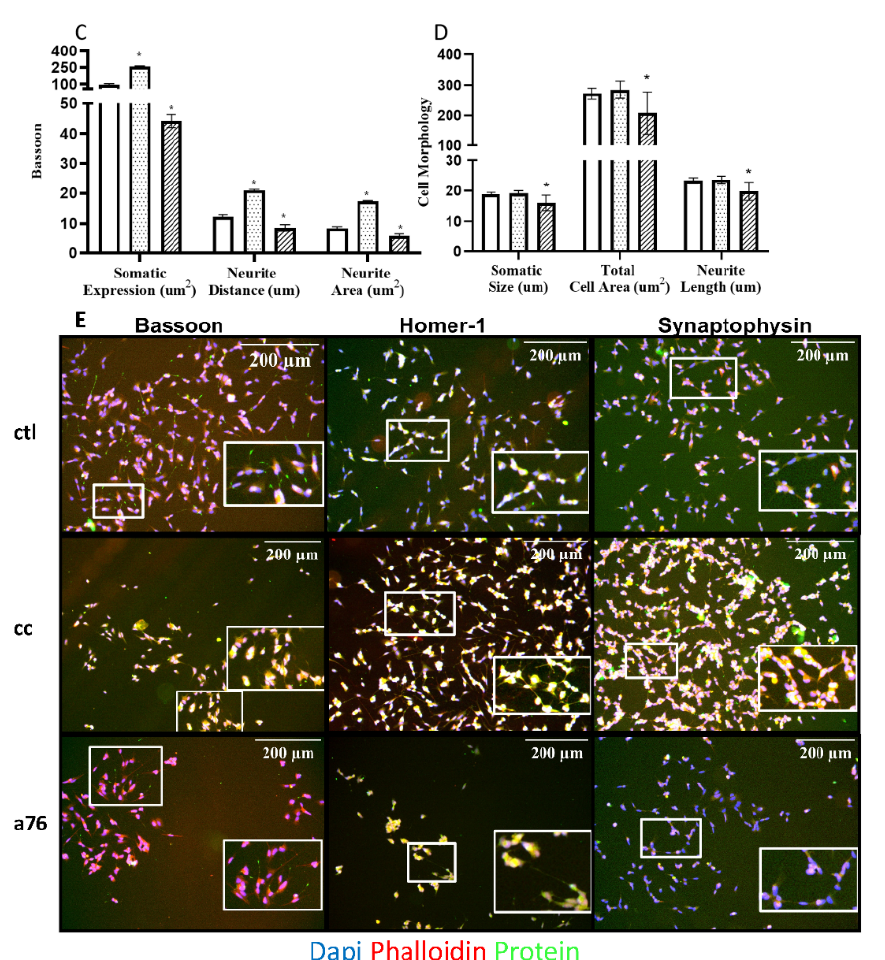
Figure 4. Chronic effects of Compound C (CC) and A-769662 (A76) on regulating cell morphology, protein content, and cellular location of synaptic markers. Total cell area (total protein content), projection length (distance of protein expression in projections), and projection area expression (projection protein content) for synaptophysin ( A ), Homer-1 ( B ), Bassoon ( C ), and change in neuron size (cell diameter), area (total cell size), and projection length ( D ) in SH-SY5Y cells relative to ctl following 5 d of A-769662 (100 nM) and Compound C (nM) treatment. Representative IF images shown below ( E ) for Bassoon, Homer-1, and Synaptophysin (N = 2–3, ~700–2500 cells per N) following 5 d of A-769662 (100 nM) and Compound C (30 nM) treatment. DAPI nucleus stain shown in blue, phalloidin cytoskeleton actin stain shown in red, and each protein of interest shown in green. Representative images are combinations of all 3 channels. Insets with increased magnification for each representative are shown by a bold, white border. Results represent independent experiments (n = 5–6). All stitched montage images were preprocessed for background flattening (rolling ball diameter 628 um, 210 pixels) on all channels before cellular analysis. Data are presented as mean ± SEM. * Indicates significant ( p < 0.05) difference from ctl as determined using a one-way ANOVA followed by Tukey’s post hoc analysis.